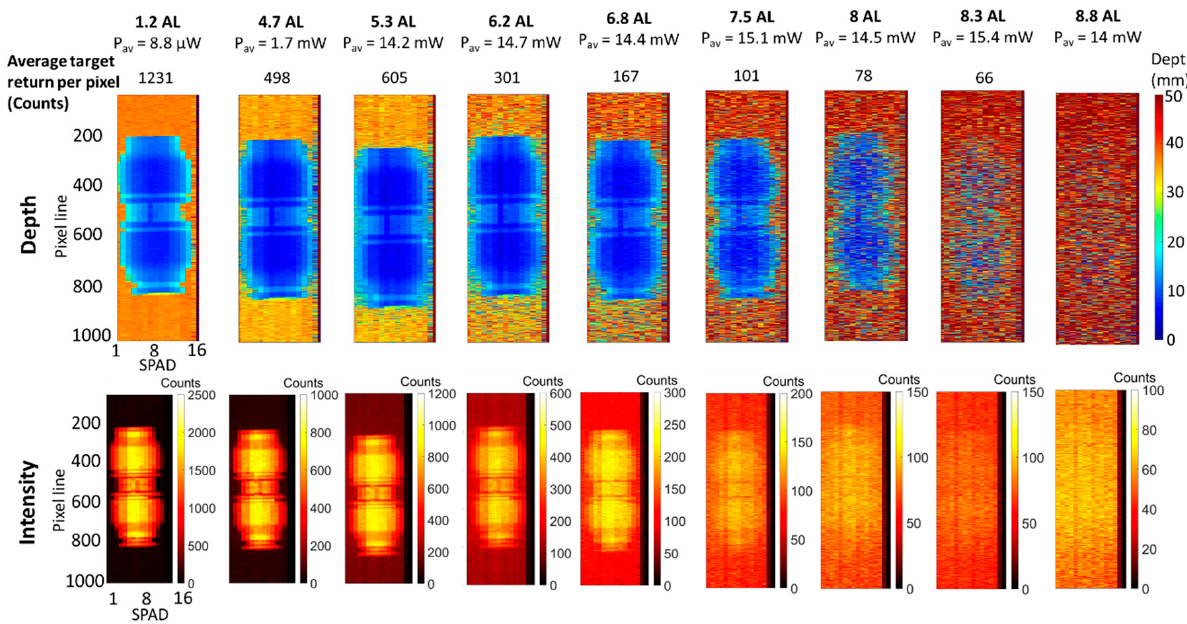
Figure 5. Depth ( top line ) and intensity ( bottom line ) profiles of the plastic pipe target in unfiltered tap water and several concentrations of scattering agent. The data were analyzed with the pixel-wise cross-correlation approach, the acquisition time per line was set to 10 ms, and the average optical power was adjusted from 9 µ W to 15.4 mW, depending on the level of scattering in water. The average target return for each scan was obtained by averaging the count rate of the 8 SPAD detectors in the central part of the target over the 10 ms acquisition time.